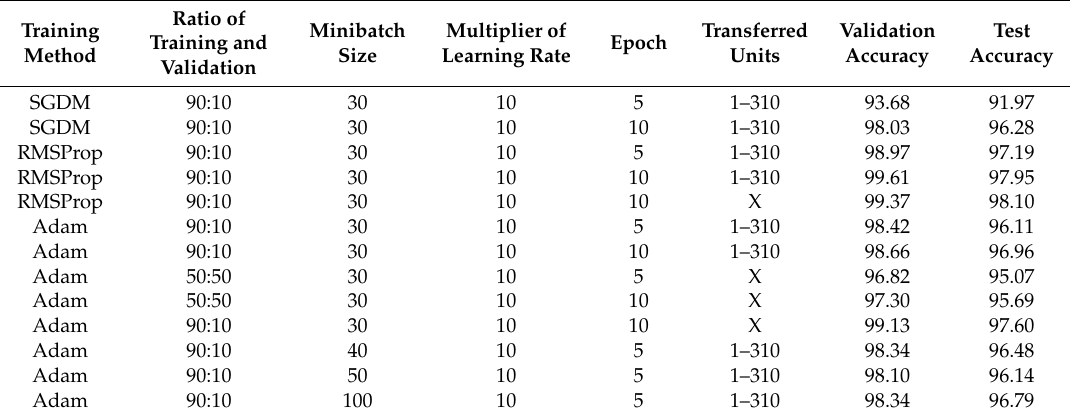
Table 4. Performance of ResNet on PTB-ECG.